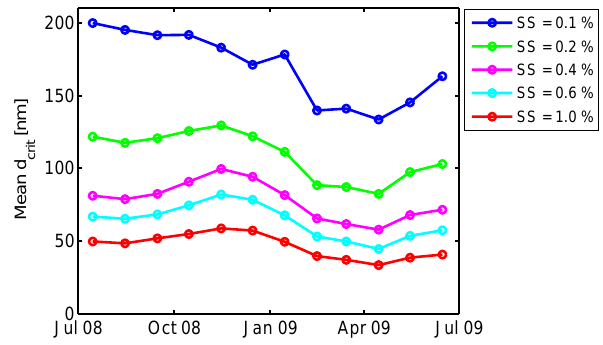
Fig. 4. Monthly mean values of critical diameter estimated from the CCN concentrations and size distribution